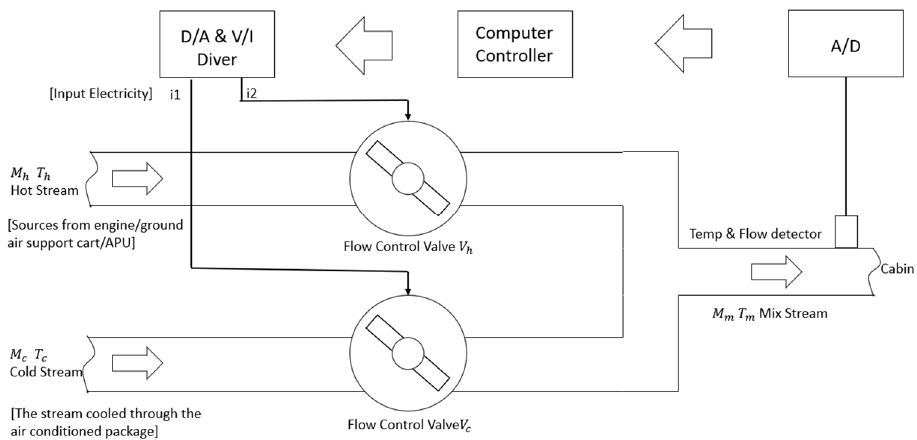
Figure 1. Diagram of cockpit flow and temperature control system.